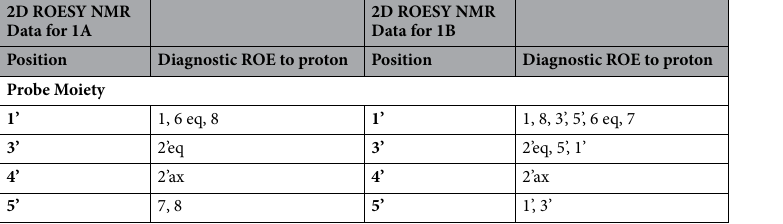
2D ROESY NMR Data for